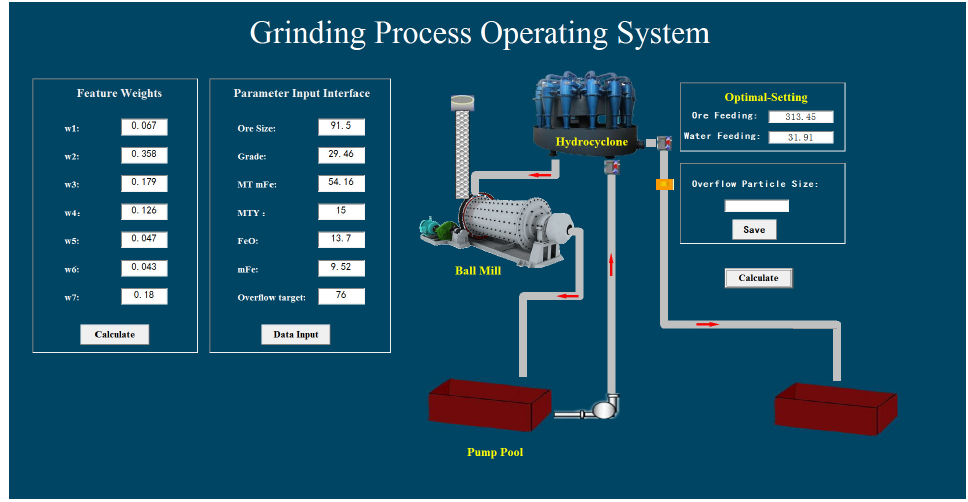
Figure 9. Human–computer interaction